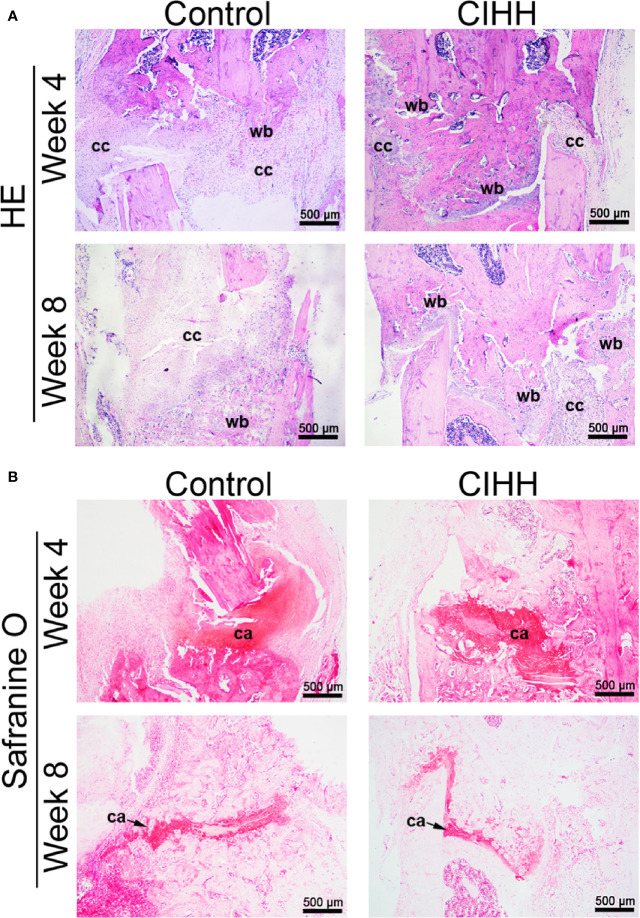
Histological evaluation of fracture. (A) HE staining of fracture callus sections. (B) Safranine O staining of fracture callus sections. Magnification, ×40; scale bar = 500 µm. The typical images from 6 repeats were shown. wb, woven bone; cc, cartilaginous callus; ca, cartilage area.